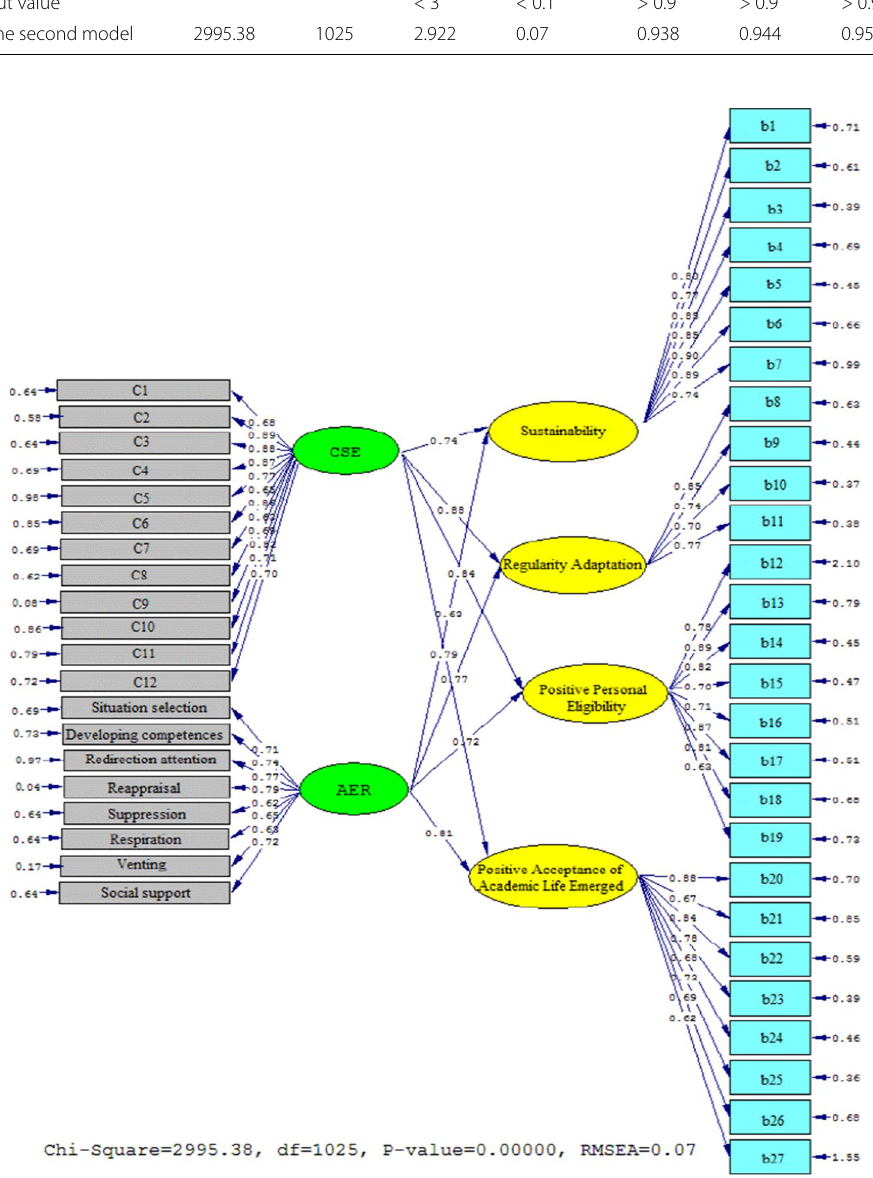
Fig. 4 Schematic representation of path coefficient values for the relationships between AER, CSA, and AB subscales (model